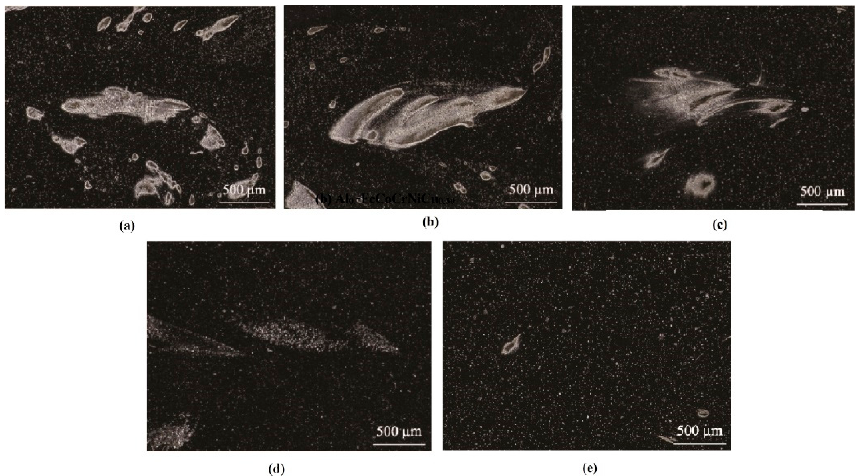
Figure 4. SEM images of corrosion morphology of Al 0.7 FeCoCrNiCu x high-entropy alloy coatings with different Cu contents. ( a ). Al 0.7 FeCoCrNi; ( b ). Al 0.7 FeCoCrNiCu 0.30 ; ( c ) Al 0.7 FeCoCrNiCu 0.60 ; ( d ). Al 0.7 FeCoCrNiCu 0.80 ; ( e ). Al 0.7 FeCoCrNiCu 1.00 .